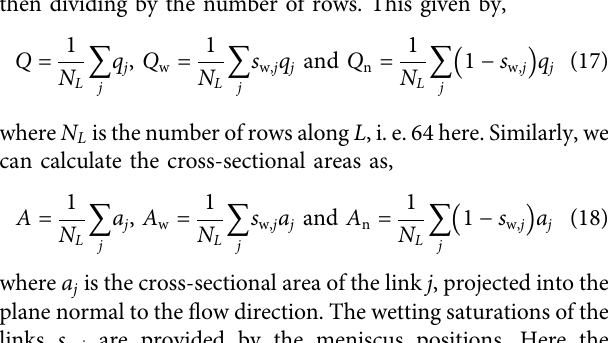
Frontiers in Physics |